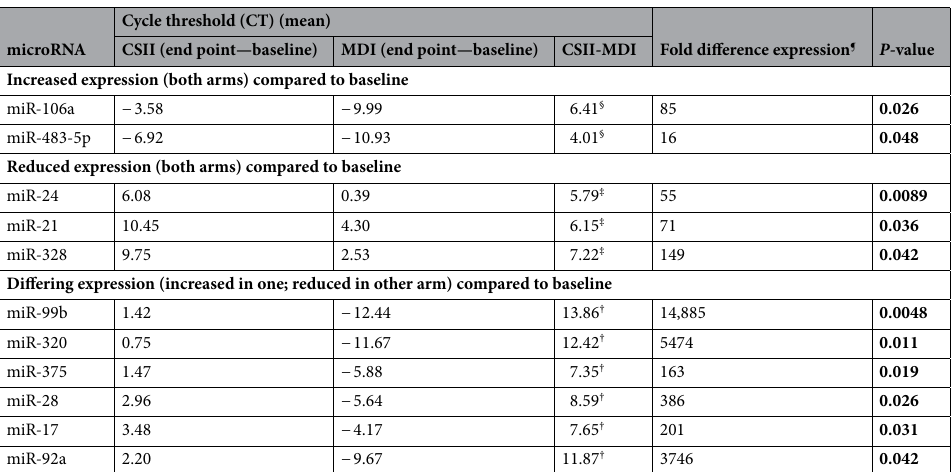
Table 1. Fold difference in microRNA expression CSII compared to MDI therapy at study end-point. Positive endpoint—baseline value indicates higher CT level (lower expression) at the end of follow-up. Negative value indicates lower CT level (higher expression) at the end of follow-up relative to baseline. † Expression at endpoint relative to baseline reduced in CSII, and increased in MDI. ‡ Expression at endpoint relative to baseline reduced in CSII, smaller reduction in MDI. § Expression at endpoint relative to baseline increased in CSII, greater increase in MDI. ¶ Calculated as 2^(CSII-MDI). Significant P -values are highlighted in